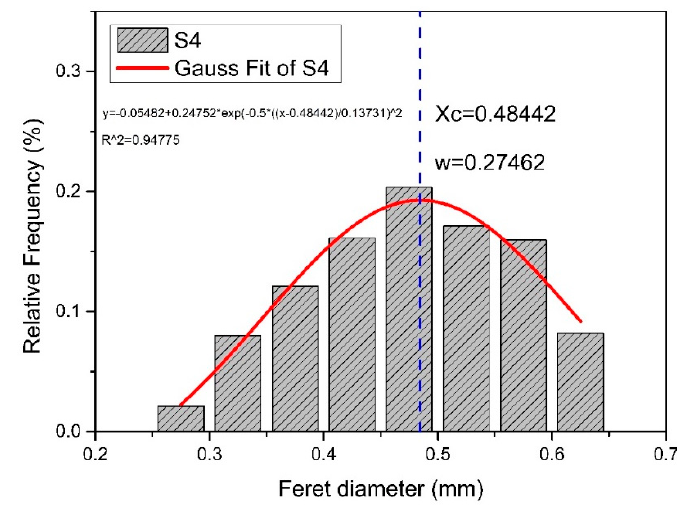
Figure 12. Gauss equation fitting curve of particle size distribution.